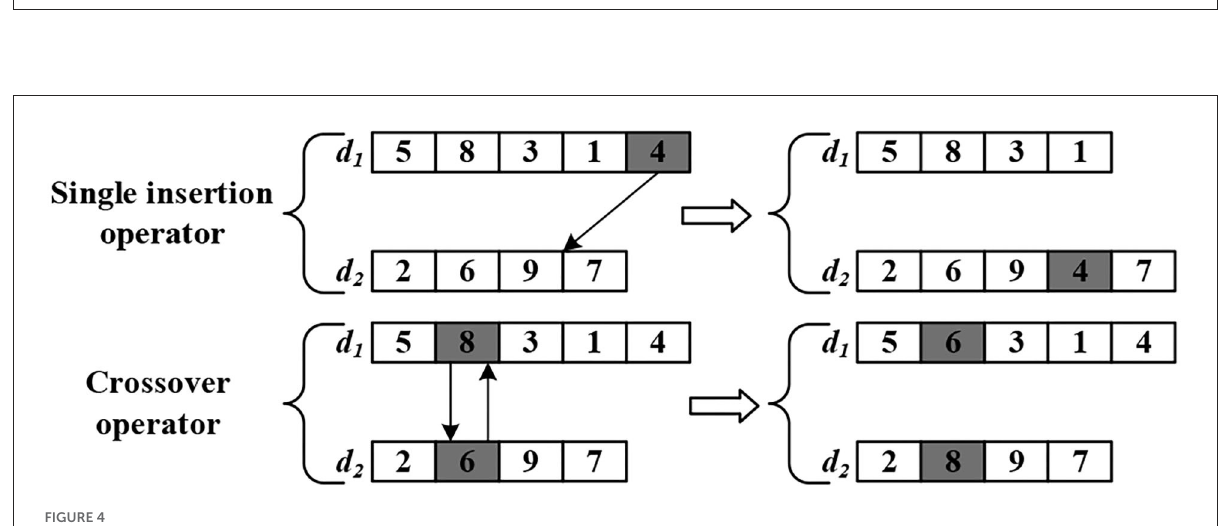
FIGURE4 A description of move